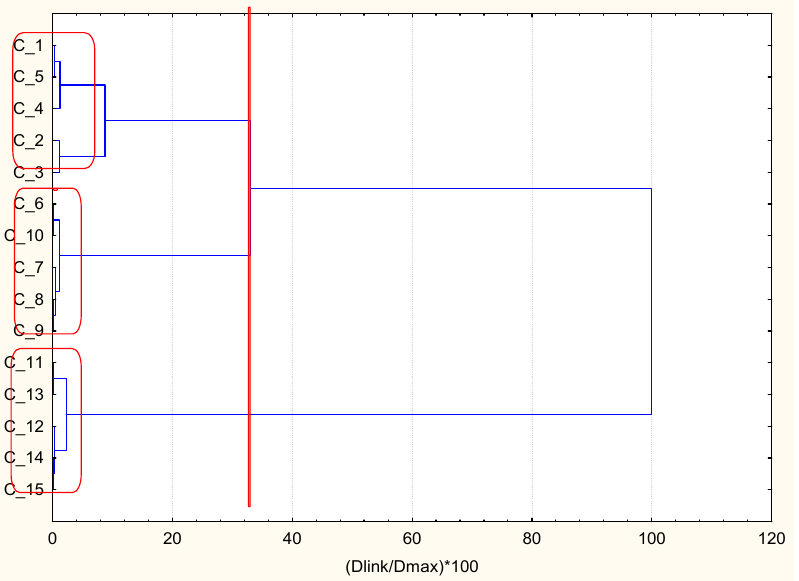
Figure 4. Hierarchical dendrogram for clustering of 15 occasionally selected patients with DMT2 and diabetic polyneuropathy (DPNP) as underlying diseases.